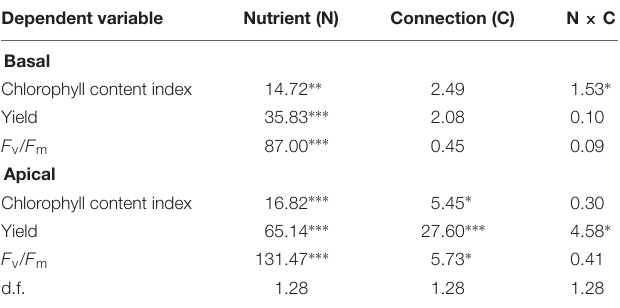
TABLE 2 | Two-way ANOVA analyses for the effects of soil nutrient and stolon connection on the chlorophyll content index and chlorophyll fluorescence (yield and F v / F m ) of Alternanthera philoxeroides for the basal part, apical part, and whole clonal fragment.